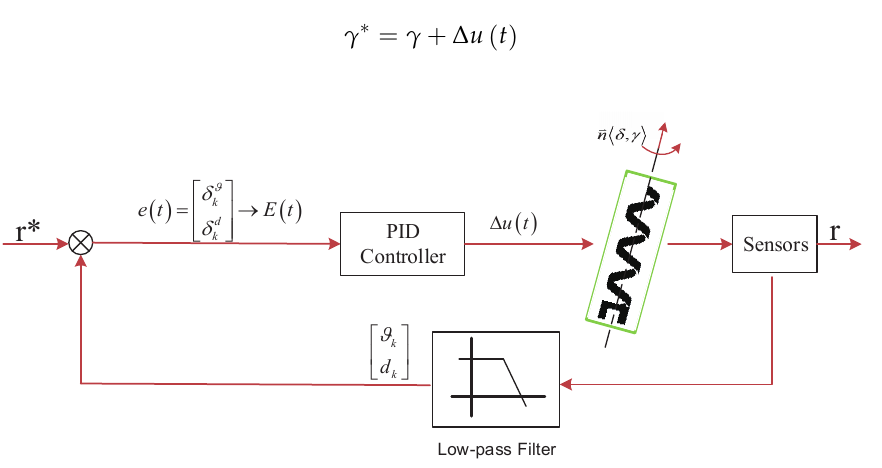
Figure 7. Block diagrams of the 2D path following